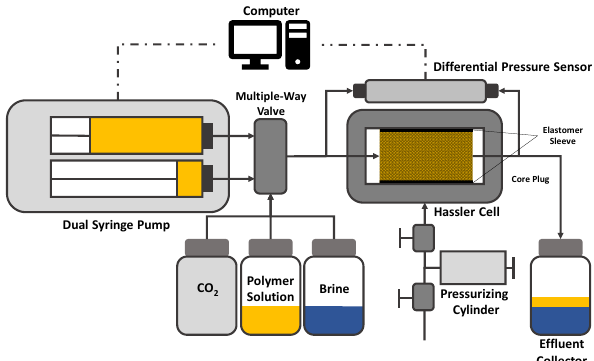
Figure 14. Schematic sketch of a core flooding setup used for experiments at room temperature. For experiments at elevated temperatures the Hassler cell and inlet/outlet pipes are placed in an oven.